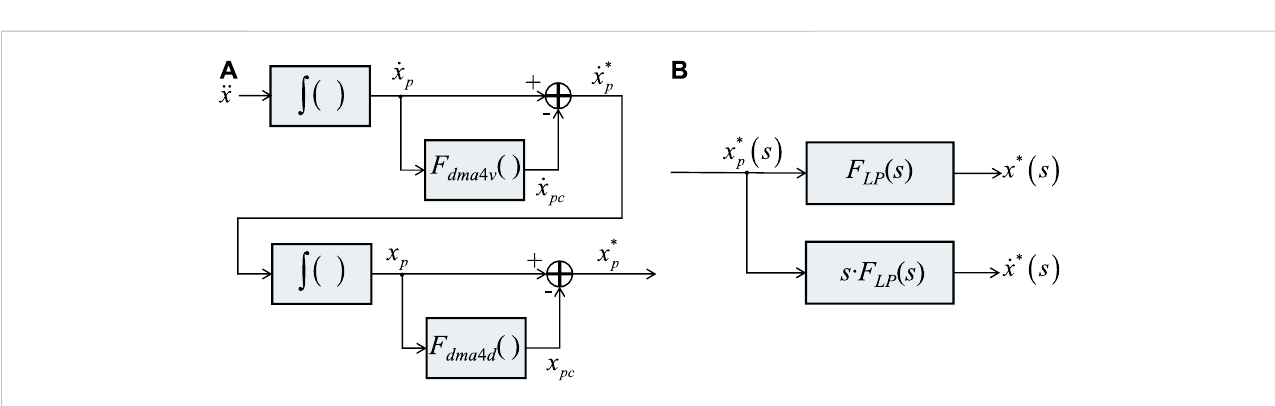
FIGURE 3 Structural response estimation in SPLiTS4a: (A) minimisation of central-point shift components by two-pass moving-average fi lters, F dma 4 v and F dma 4 d , whichcorrespondtoEqs12,14,respectively, and (B) Structural responsesgeneratedbydisplacementdatawiththeminimised central-pointshiftcomponent.